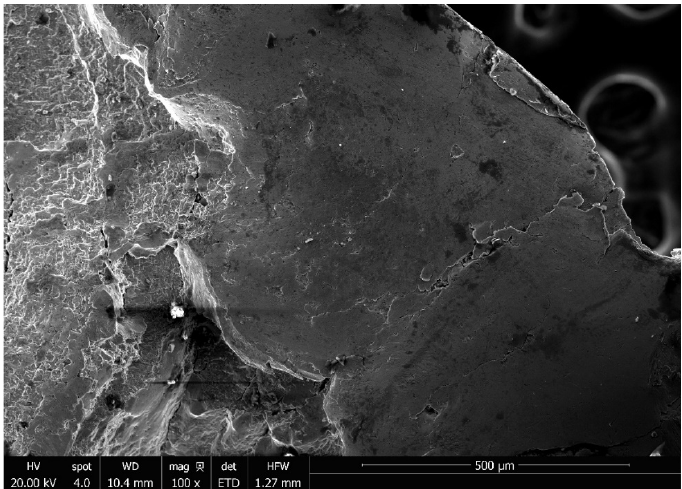
Figure 12. Topographical SEM image of the fracture failure.